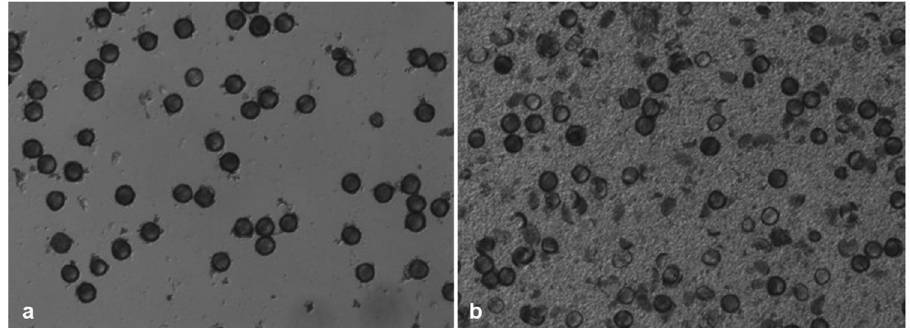
Figure 2: Microscope images (× 100 ) and size distribution of pollen ( a ) and pollen@FePO 4 ( b )